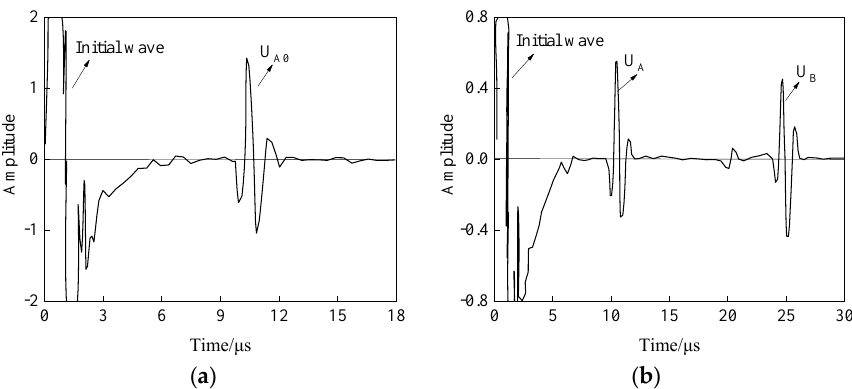
Figure 8. Schematic diagram of the experimental setup.